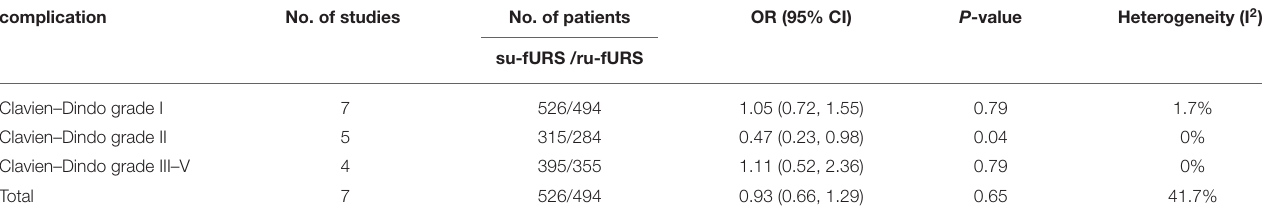
TABLE 2 | The meta-analysis of postoperative